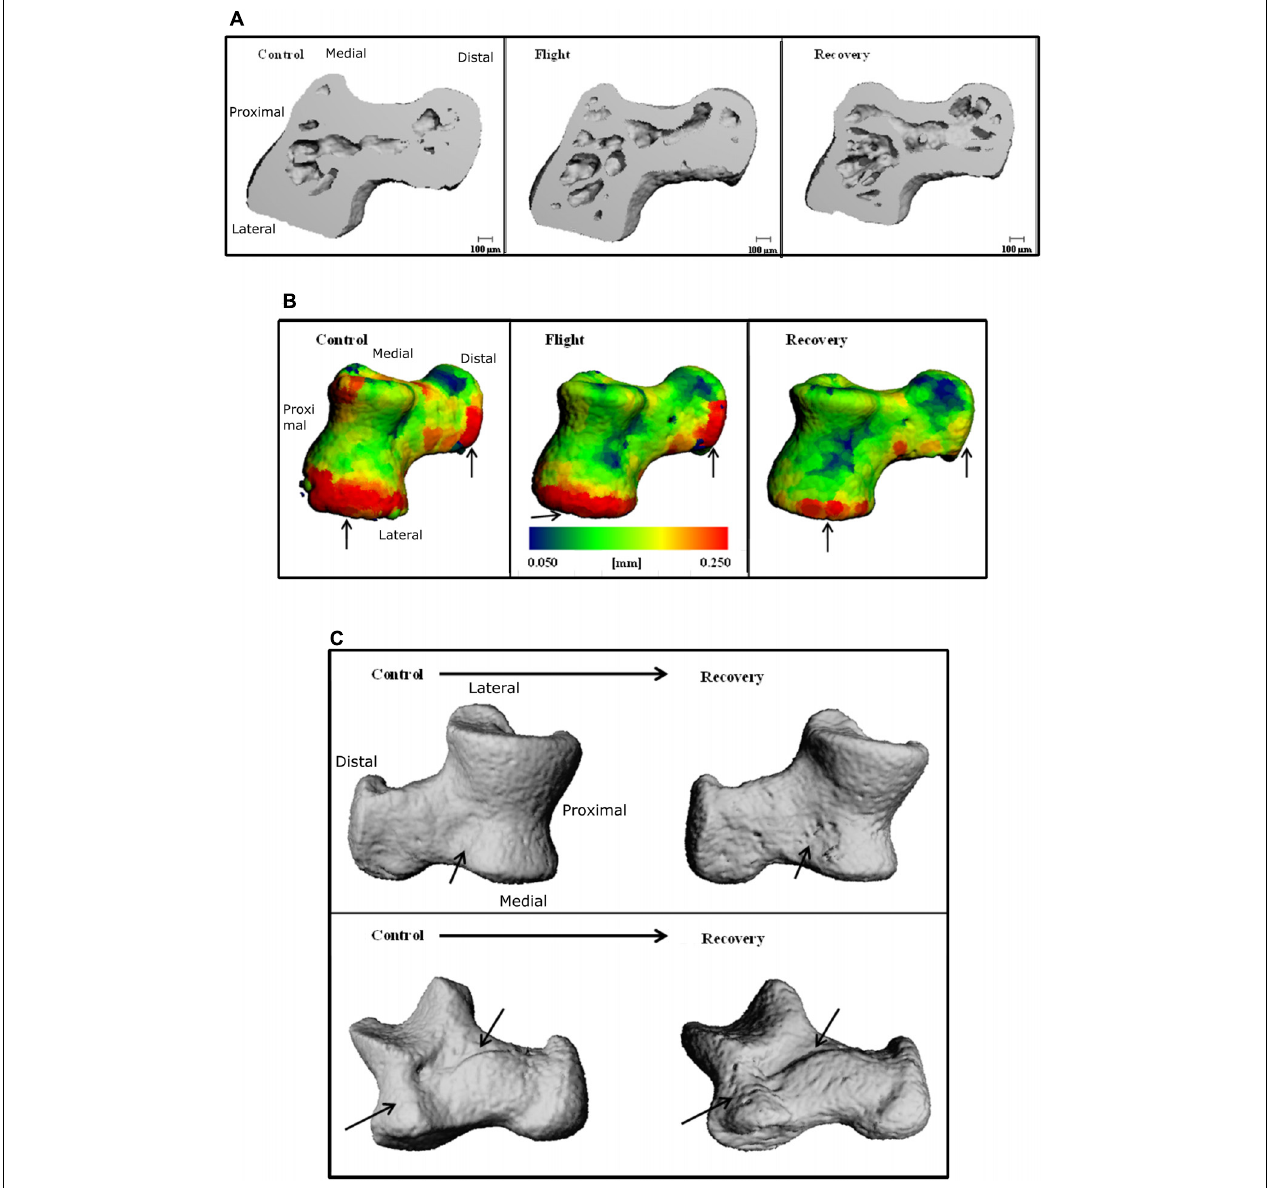
FIGURE 5 | Three-dimensional reconstructions of the talus, illustrating (A) cross-section through 3D reconstructions of talus: Control; Flight; Recovery. (B) Color maps for Ct.Th of talus blue = thinnest (0.050 mm) and red = thickest (0.250 mm) for: Control; Flight; Recovery. Arrows indicate areas of greatest changes at articulations (C) BS regions of erosion (indicated via arrow), for the talus in two positions: (Upper) control and recovery cranial aspect; (Down) control and recovery; recovery underside aspect (C)